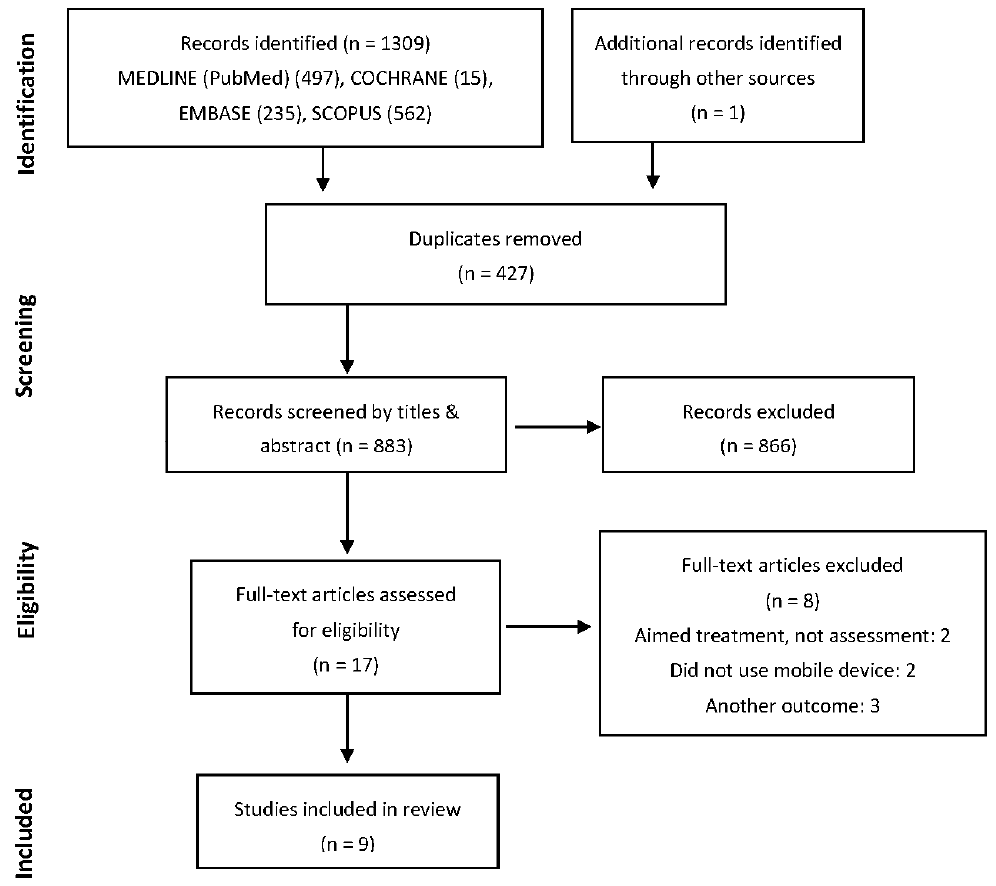
Figure 1. Flow Figure 1. Flow diagram.